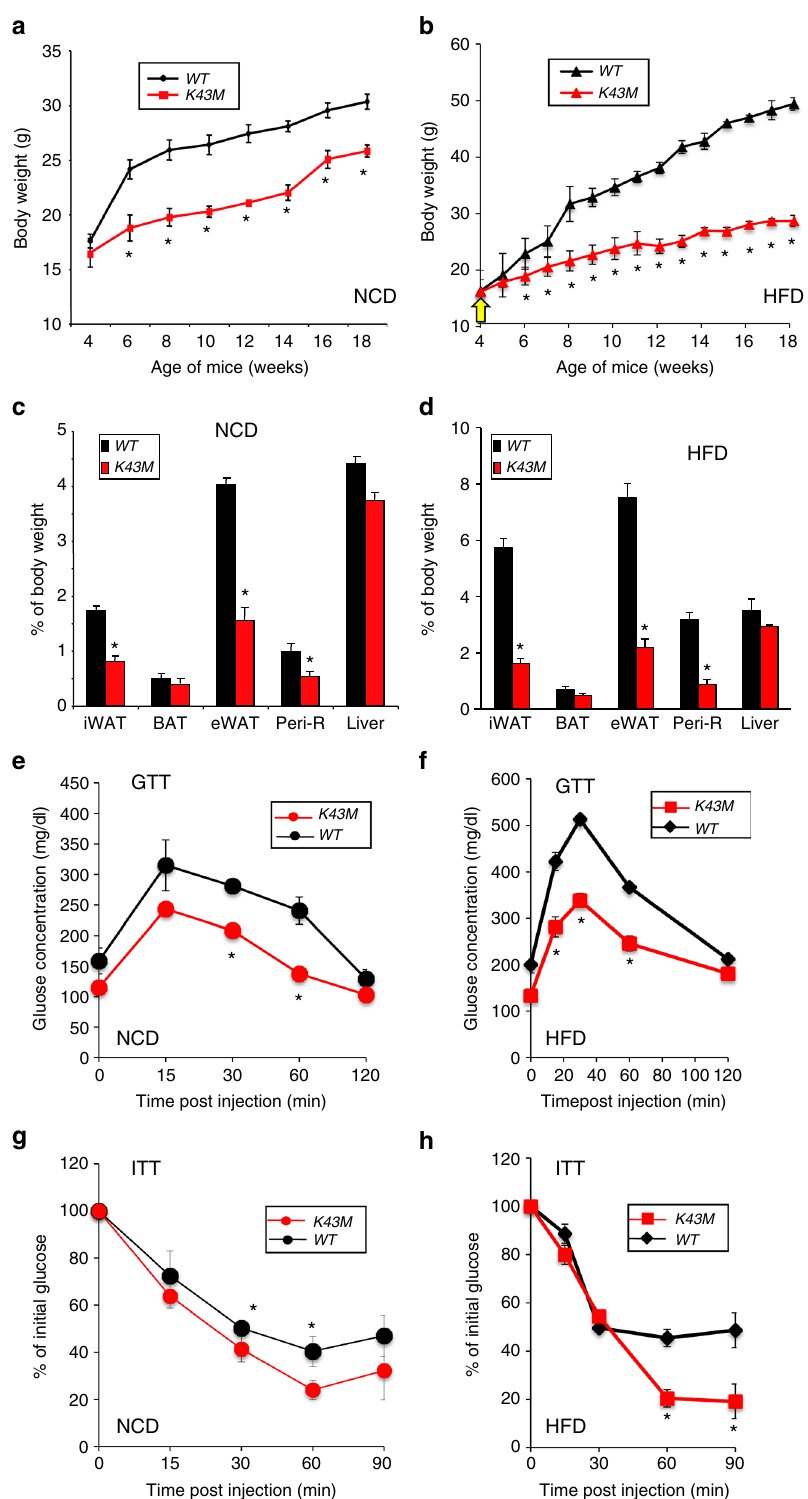
Fig. 1 Loss of CDK6 kinase activity in mice leads to an improved metabolic pro fi le. a , b Body weight of age-matched male mice on NCD ( a ) or HFD ( b ) for a 14-week observation time. HFD commenced at 4 weeks of age. c , d Mass of various fat pads was normalized to body weight of male mice on NCD ( c ) or HFD ( d ) at 18 weeks of age. No signi fi cant changes were observed in the masses of BAT and livers between WT and K43M mice under NCD and HFD. e , f GTT after 14 weeks on NCD ( e ) or HFD ( f ). g , h ITT after 14 weeks on NCD ( g ) or HFD ( h ). For a – h , data shown are mean ± S.E. ( n = 10 for each group), * p < 0.05, t -test, vs WT . See also Supplementary Figs. 2 and